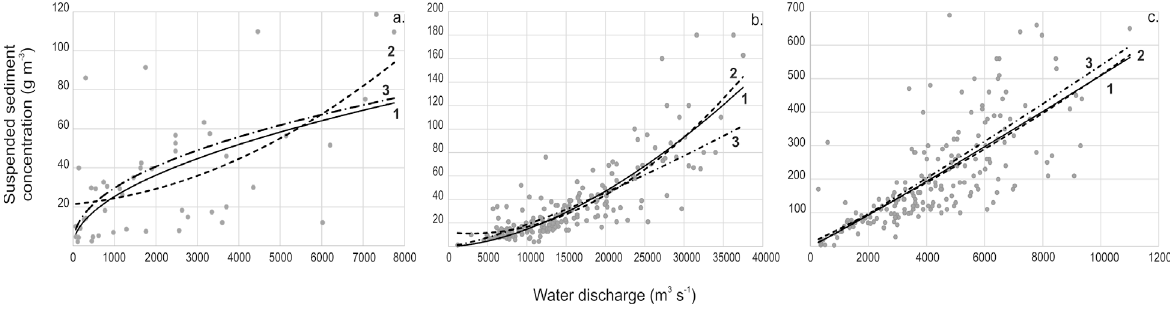
Fig. 4 Sediment rating curves for the Anabar River at (a) Saskylakh, (b) the Lena River at Tabaga and (c) the Indigirka River at Vorontsovo, obtained using non-linear power fit (1), non-linear power fit with additive constant (2) and log-linear fit (3). Table 4 Nash-Sutcliffe efficiencies of the rating curves. Anabar at Saskylakh Lena at Tabaga Indigirka at